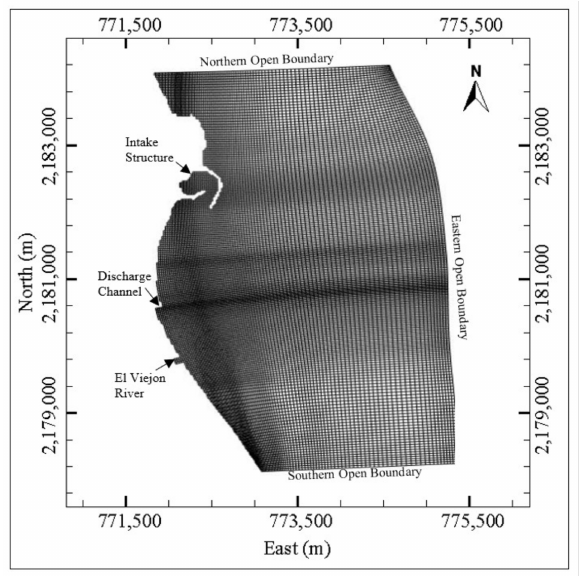
Figure 4. Grid and boundary conditions used in the numerical